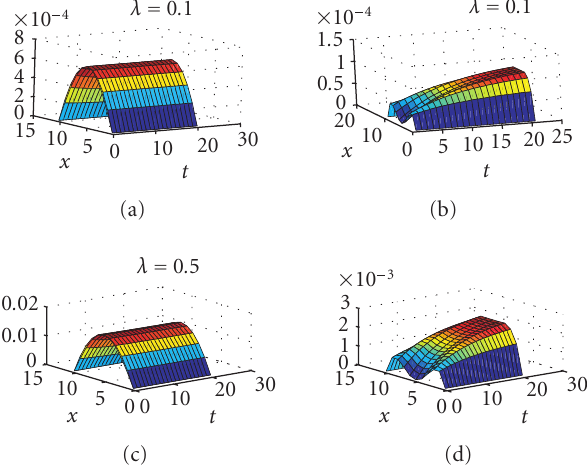
Figure 4.6. The lower solutions w ( x , t ) and v ( x , t ) and the di ff erence v ( x , t ) − w ( x , t ) for the slab ge- ometry, when β = 0 . 5, δ = 0 . 1, and λ = 0 . 1,0 . 5.